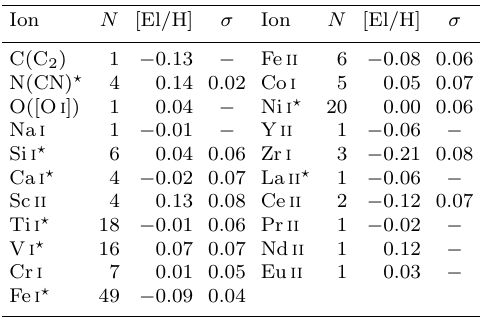
Table 3. Element abundances relative to hydrogen, [El/H]. (cid:27) is a standard deviation in the mean value due to the line-to-line scatter within the species. N is the number of lines used for the abundance